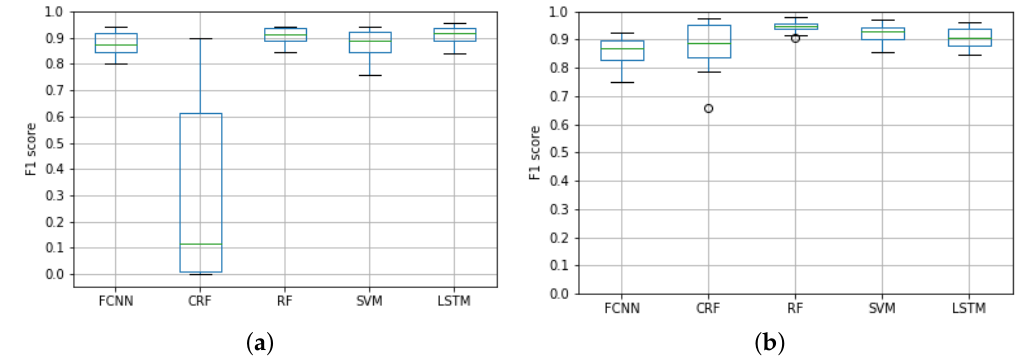
Figure 12. Average F1 score per zone and hour of each of the evaluated models considering both the OSN data and the taxi demand as input. ( a ) F1 score of QUADRIVEN models; ( b ) F1 score using taxi demand data.